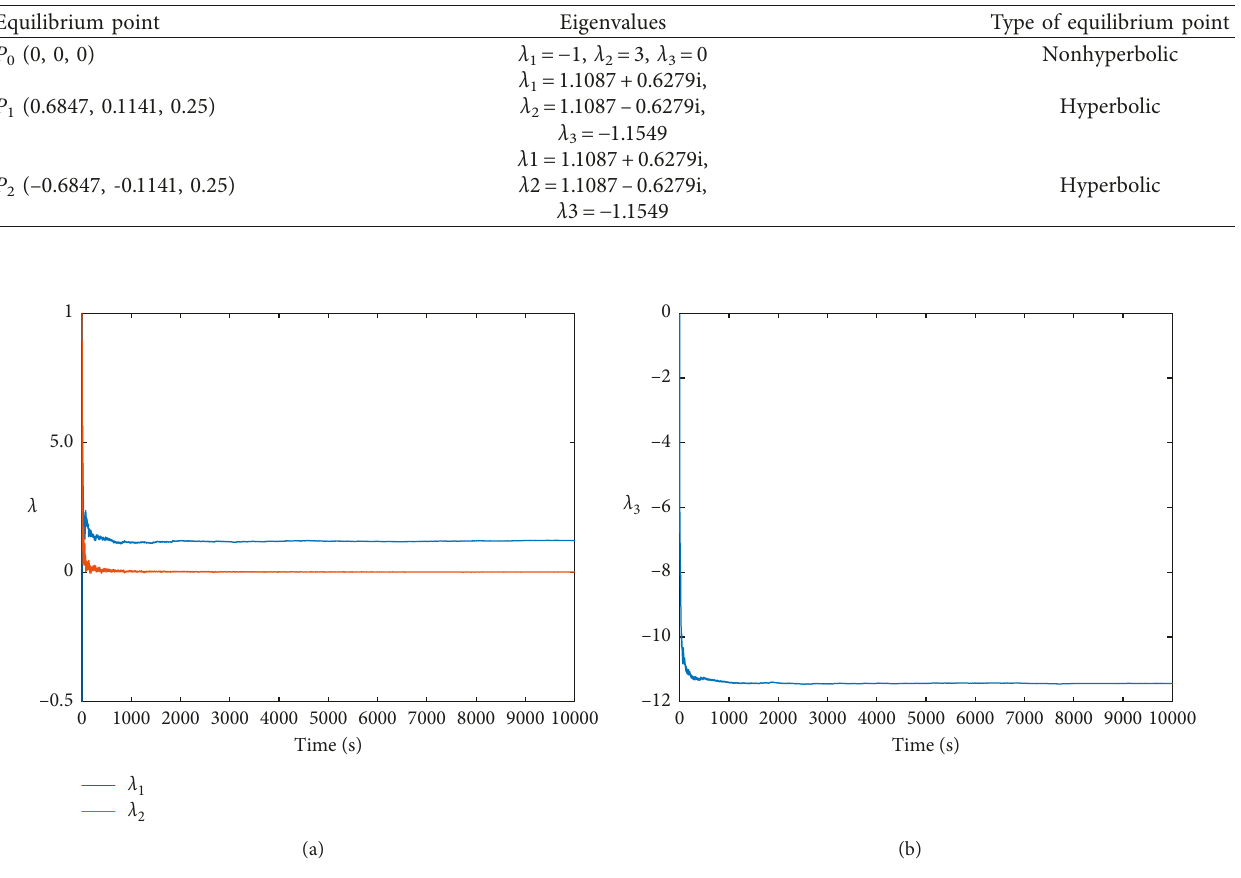
Figure 1: Lyapunov exponents of system (1) when a � 1, b � 6, c � 5, d � 1, e � 3, and f �